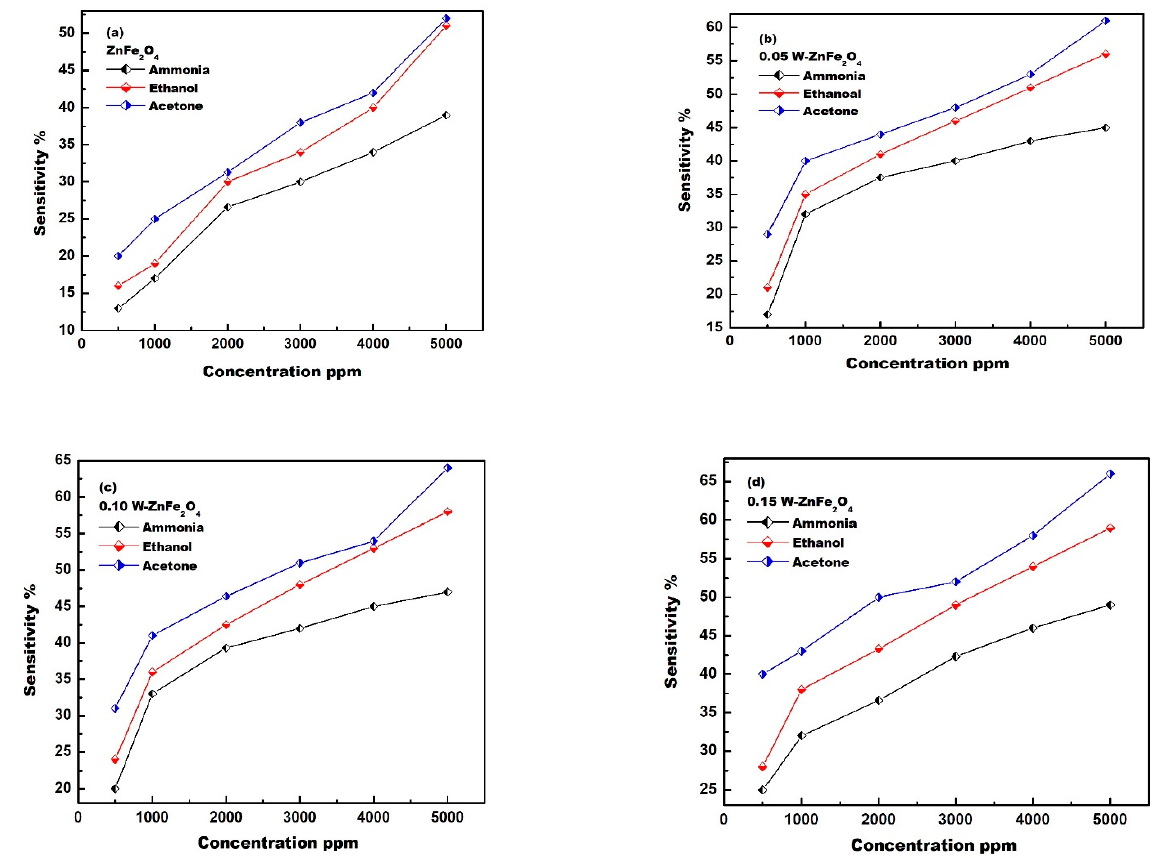
Figure 10. Gas sensitivity % at different gas concentrations (ppm) of ( a ) ZnFe 2 O 4 , ( b ) ZnW 0.05 Fe 1.95 O 4 , ( c ) ZnW 0.1 Fe 1.90 O 4 , and ( d ) ZnW 0.15 Fe 1.85 O 4 .